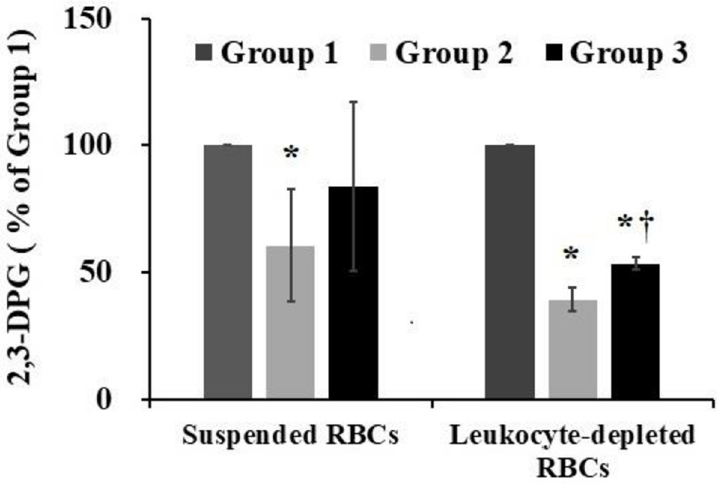
Fig 5. The 2,3-DPG contents were determined by a test kit according to the manufacturer’s instructions. Group 1 were the 1 st day fresh-collected RBCs, group 2 was the 14 th day RBCs with resting refrigerated storage, and group 3 was the 14 th day RBCs after plateau transportation. The data represent mean ± SD from five RBCs samples in each group. � p < 0.05 compared to group 1; †p < 0.05 compared to group 2.